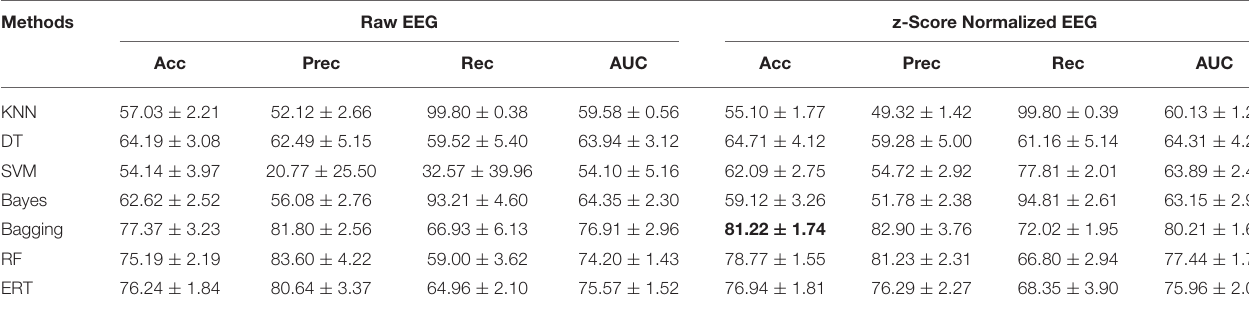
TABLE 8 | Performance criteria of conventional ML classifiers. Methods